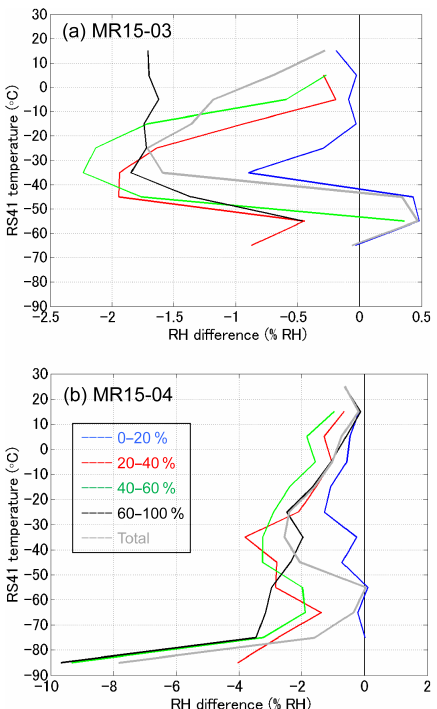
Figure 5. Mean difference in relative humidity between the RS92 and RS41 radiosondes (RS92–RS41) as a function of the RS41 temperature for relative humidity ranges of 0–20% (blue), 20–40% (red), 40–60% (green), 60–100% (black), and 0– 100% (gray). (a) MR15-03 and (b) MR15-04.